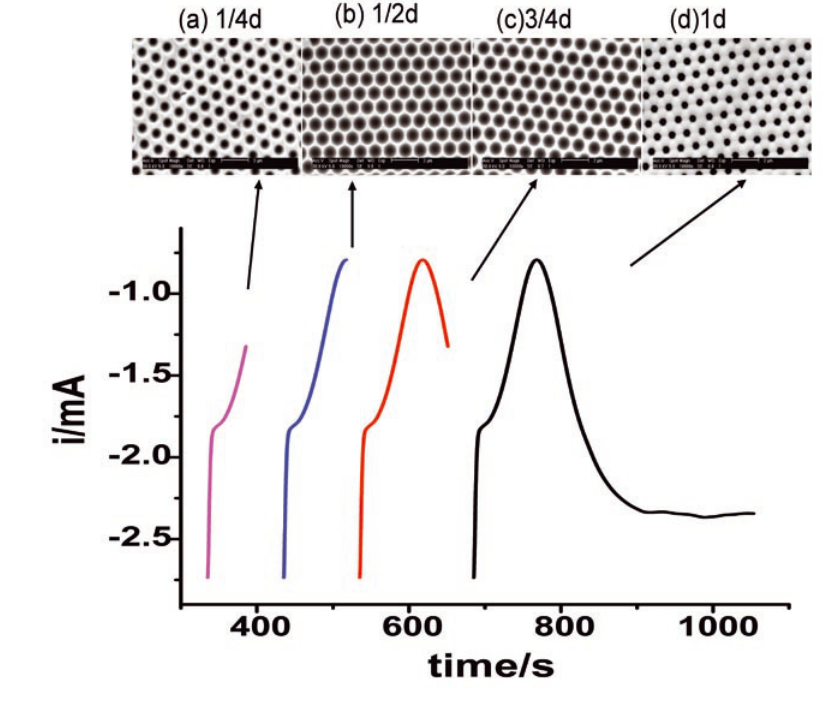
Figure 2. Current-time curves together with corresponding SEM images for gold templated films made using polystyrene spheres of 1000 nm diameter. The Electrodeposition potential was – 0.7 V vs. SCE. The films have different thickness of (a) 1/4d; (b) 1/2d; (c) 3/4d and (d) 1 d, where is d is the sphere diameter. The individual i-t curves are off-set for